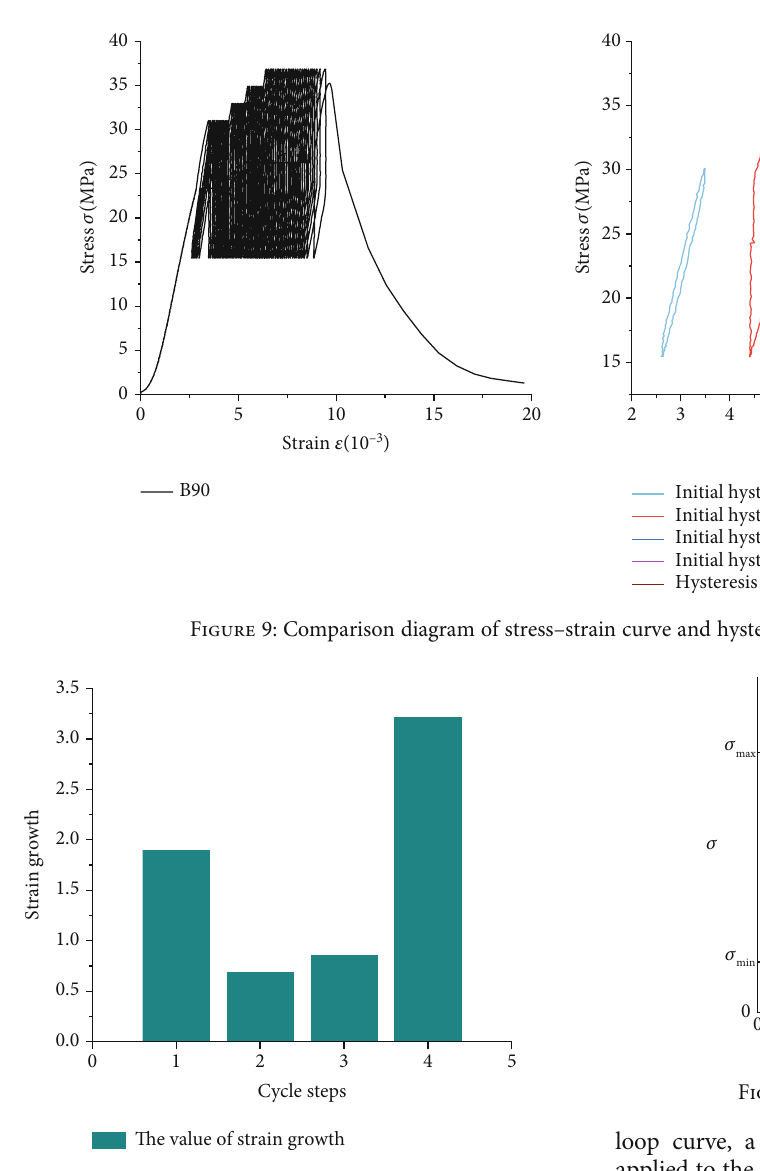
Figure 10: Variation in strain change versus cycle steps.